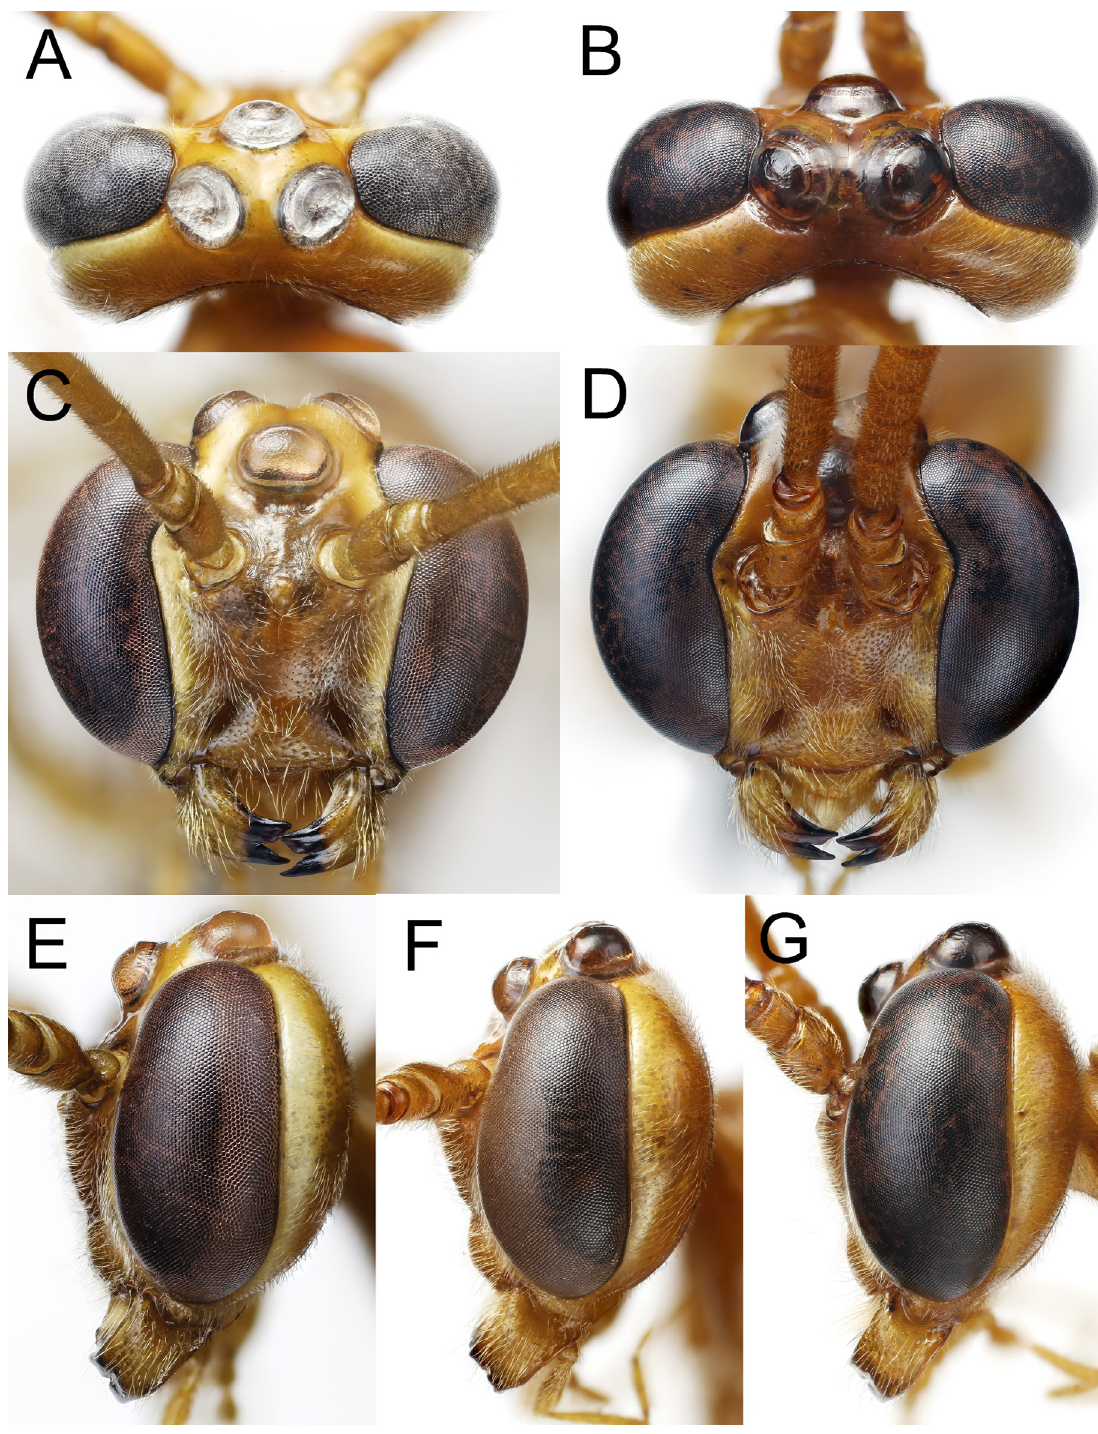
Fig. 15. A–B . head, dorsal view of female. A . Ophion splendens Johansson sp. nov . , paratype, ♀ (NhrS-hEVA000008708). B . O. brocki Johansson sp. nov., paratype, ♀